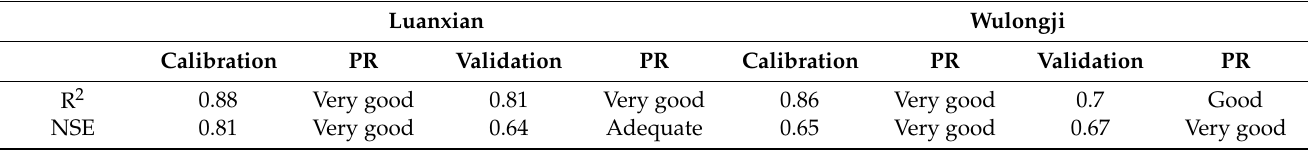
Table 1. Performance rating (PR) for streamflow prediction by